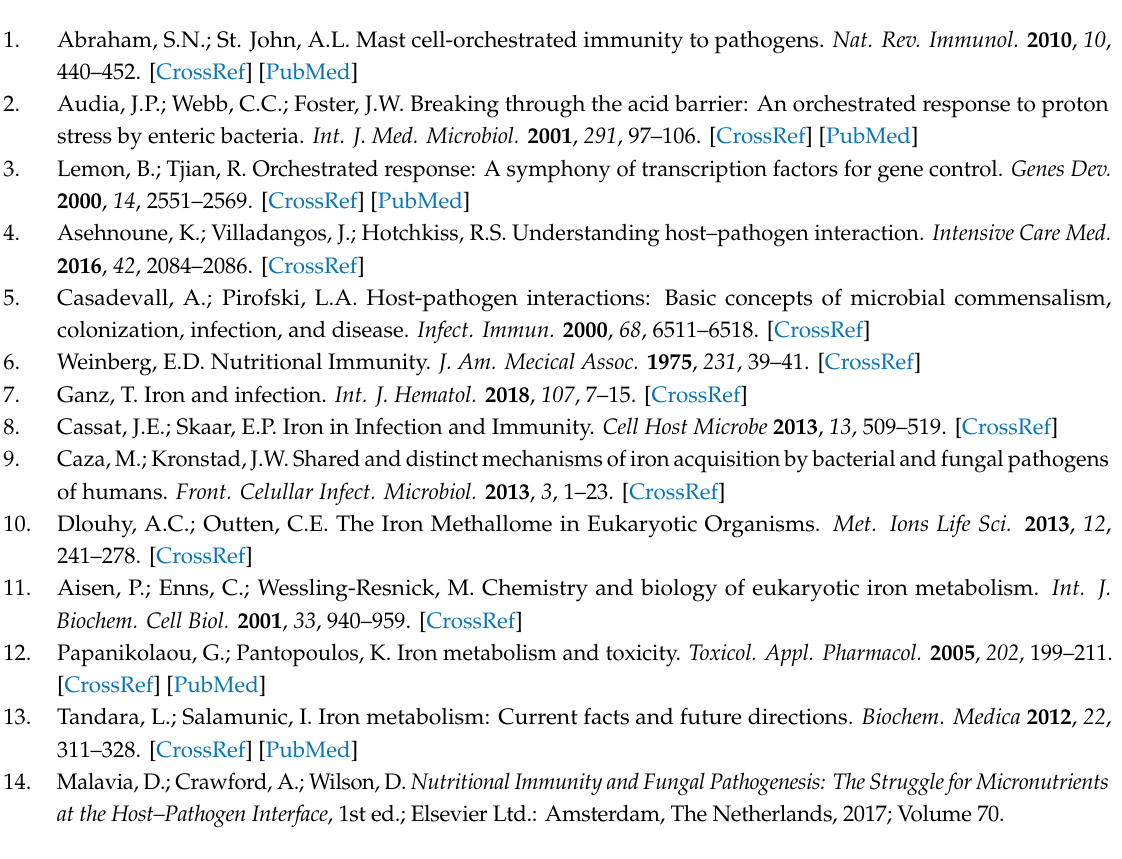
Figure S1: RMSD in molecular dynamics simulations of the models, Figure S2: 3D and 2D interactions between siderophores receptors models and carboxymycobactin, Figure S3: 3D and 2D interactions between siderophores receptors models and enterobactin, Figure S4: 3D and 2D interactions between siderophores receptors models and ferrioxamine B, Table S1: Quality of three-dimensional models after molecular dynamics simulation, Table S2: Scores of binding energies between proteins and siderophores, Table S3: Sequences of forward and reverse